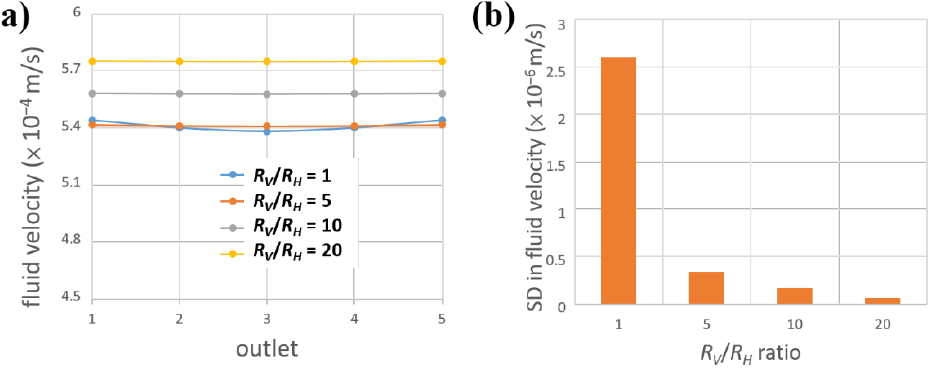
Figure 7. Simulation of fluid velocities for modified devices. ( a ) Fluid velocities in all outlets along red lines in Figure 6. ( b ) SDs in fluid velocities for four curves in ( a ).